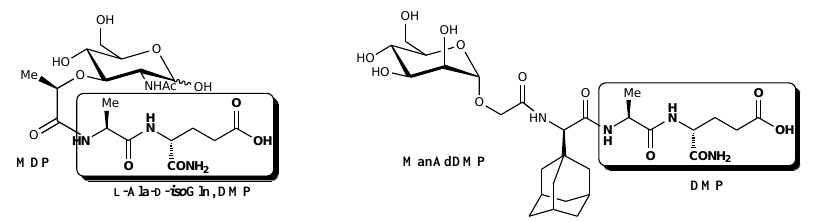
Figure 1. Structure of MDP, adamantane-containing DMP, and its mannose derivative.